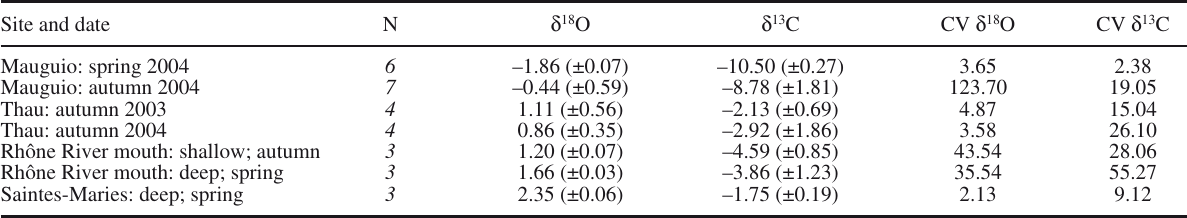
Table 3. – Mean (±sd) otolith d 13 C and d 18 O for Solea solea caught from four sites in the NW Mediterranean expressed in ‰ versus PDB. Variations in ratios are indicated by the coefficient of variation (CV). Site and